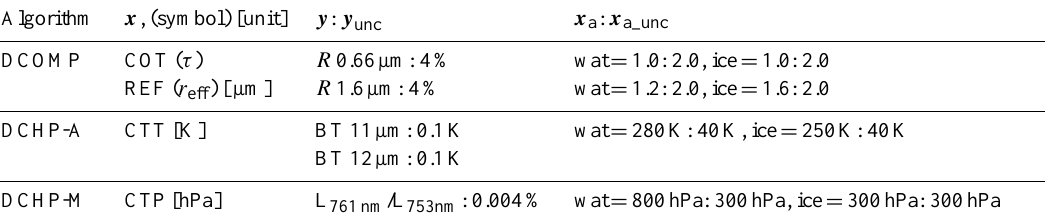
Table 2. Listed are the variables in the state vector x , the measurements in the measurement vector y ( R : reflectance; BT: brightness temperature; L : radiance) and their uncertainties y unc , and the a priori values in the a priori state vector x a and their uncertainties x a_unc , used in the Daytime Cloud Optical and Microphysical Cloud Properties retrieval (DCOMP) and both Daytime Cloud Top Height properties retrievals for AATSR measurements (DCHP-A), and MERIS measurements (DCHP-M). Here, wat and ice are the water and both Daytime Cloud Top Height Properties retrieval for ice cloud phases, respectively. Note that x a and x a_unc are in log 10 space in DCOMP.